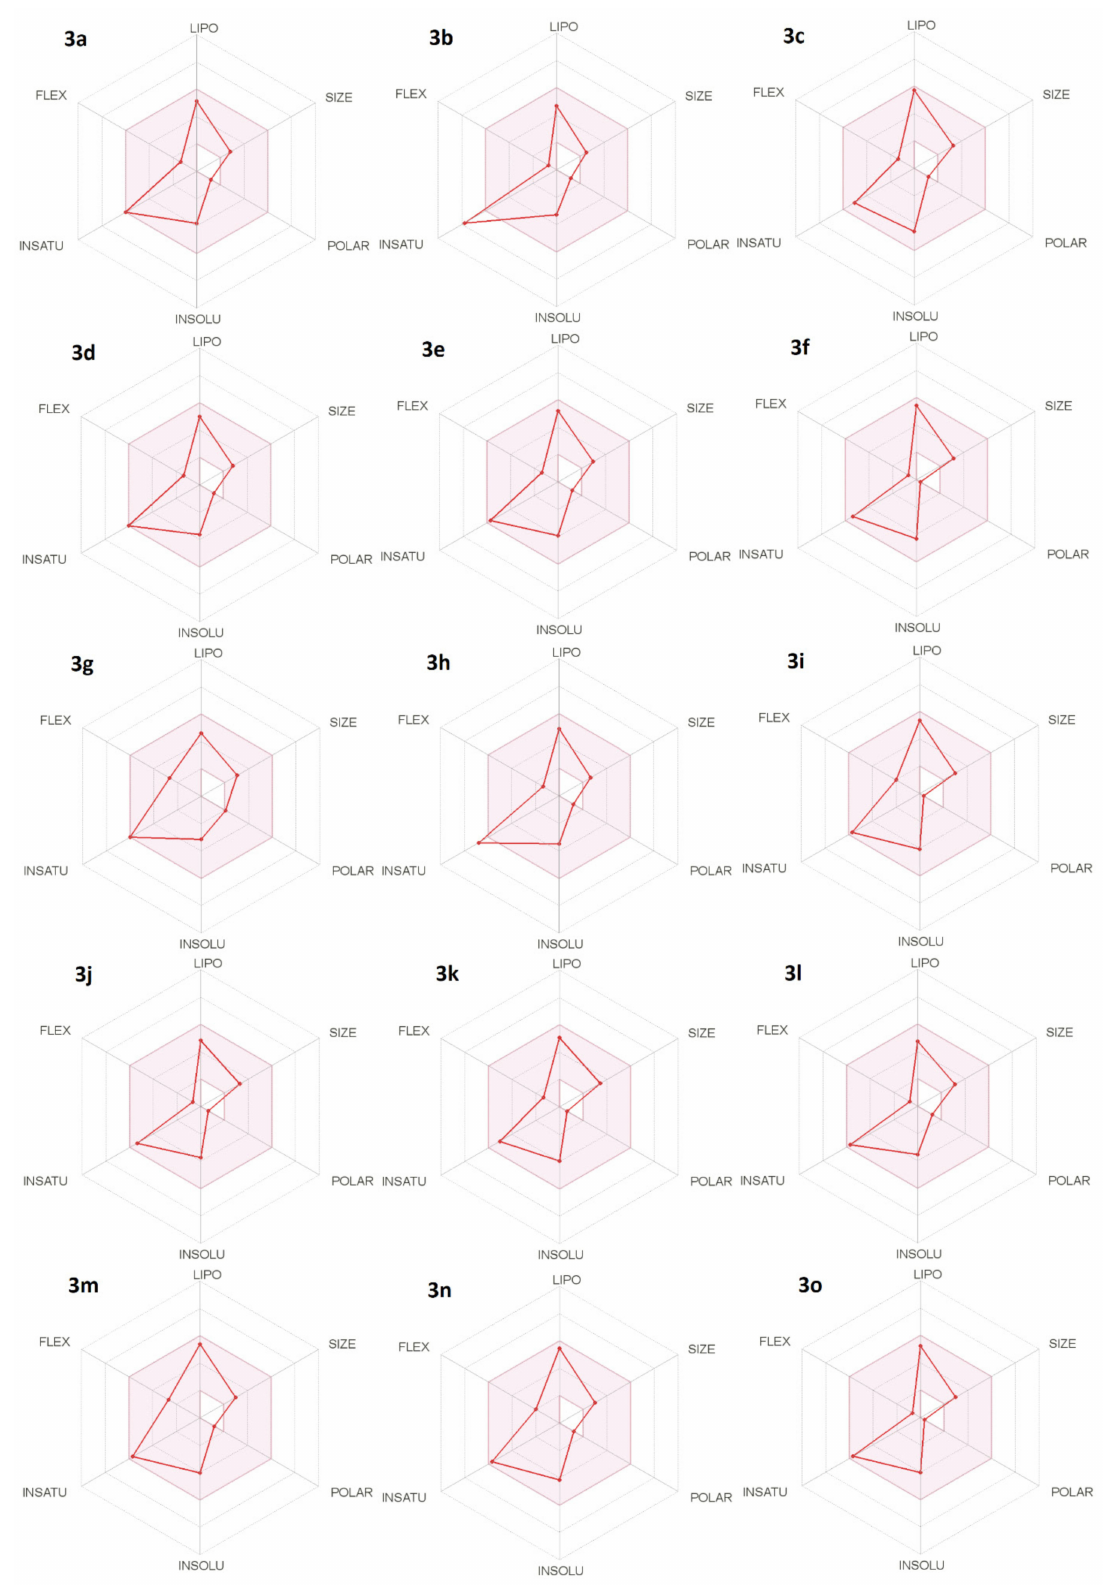
Figure 2. The bioavailability radar chart of the designed fluorene-9-amines 3a–o